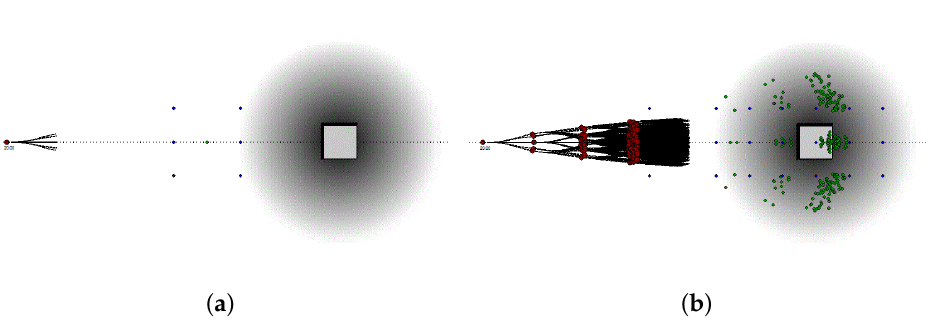
Figure 6. Obstacle avoidance example 1: Static object. The object is detected at the same location during several path-planner cycles. ( a ) reports the expansion tree with height h = 1. ( b ) indicates the expansion tree with height h = 4. The small green points represent the trajectory targets during the expansion of the rapidly exploring random tree at different tree